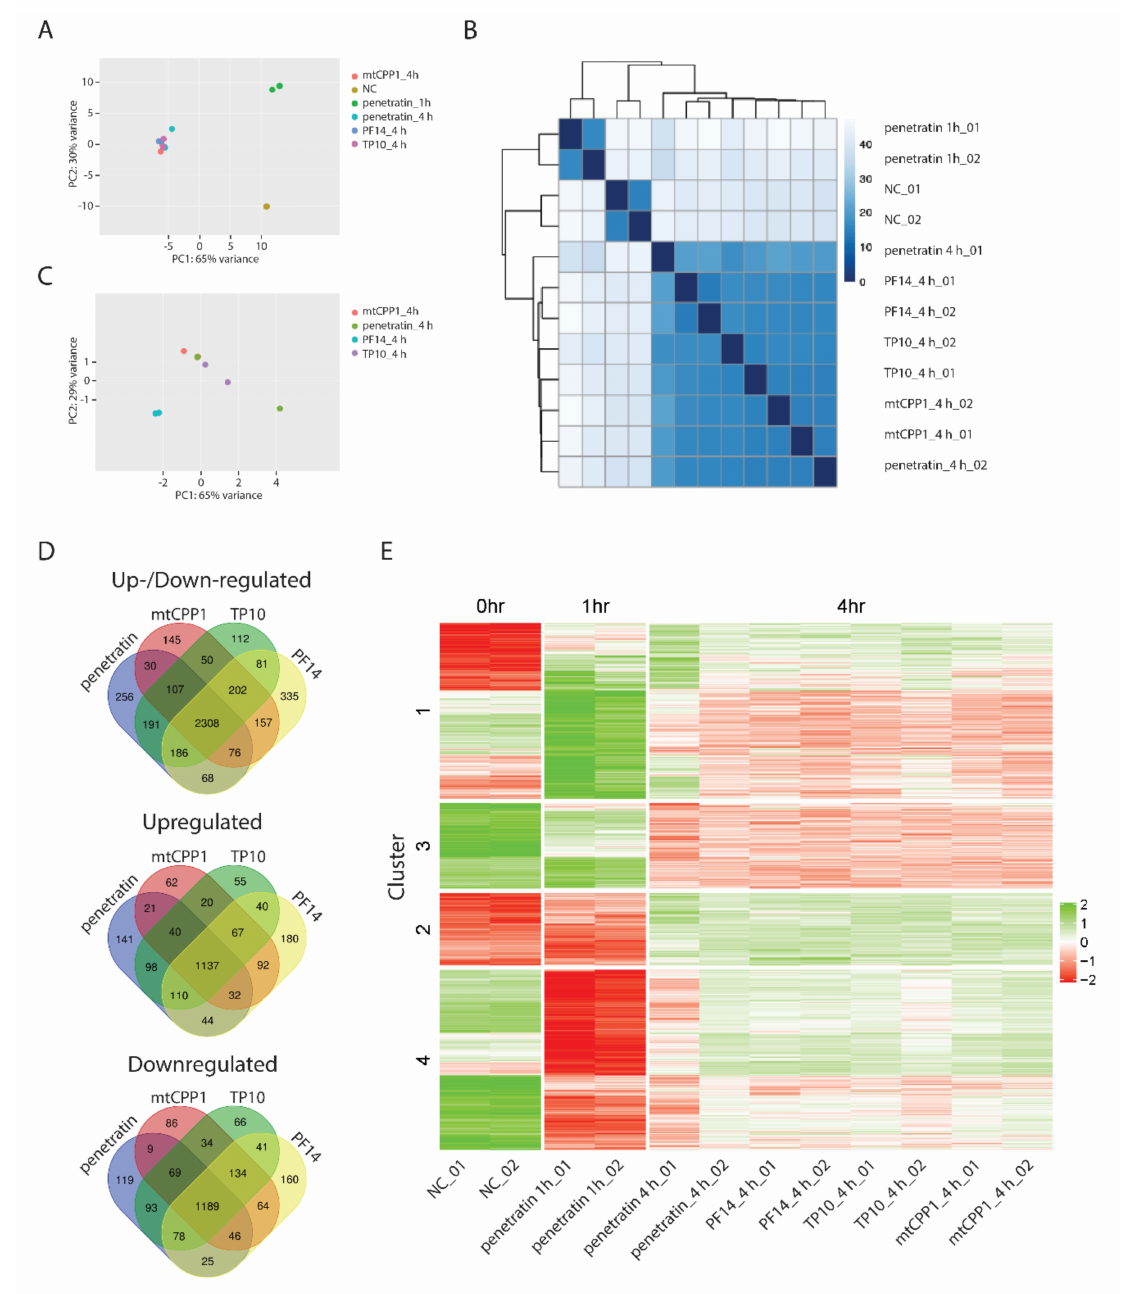
Figure 4. ( A ) PCA plot and ( B ) distance heatmap of RNA-seq samples from WT Hela untreated cells (NC), cells treated for 1 h with penetratin and cells treated for 4 h with penetratin, PF14, mtCPP1, or TP10, respectively. ( C ) PCA plot of RNA-seq samples from cells treated for 4 h with penetratin, PF14, mtCPP, or TP10. ( D ) Venn diagrams show intersection between di ff erentially expressed genes in cells treated with di ff erent cell penetrating peptides for 4 h. ( E ) Heatmap showing gene expression changes induced after 1 or 4 h by di ff erent CPPs in gene clusters identified on the basis of Penetratin treatment. Scale bar shows z-score of normalized read counts